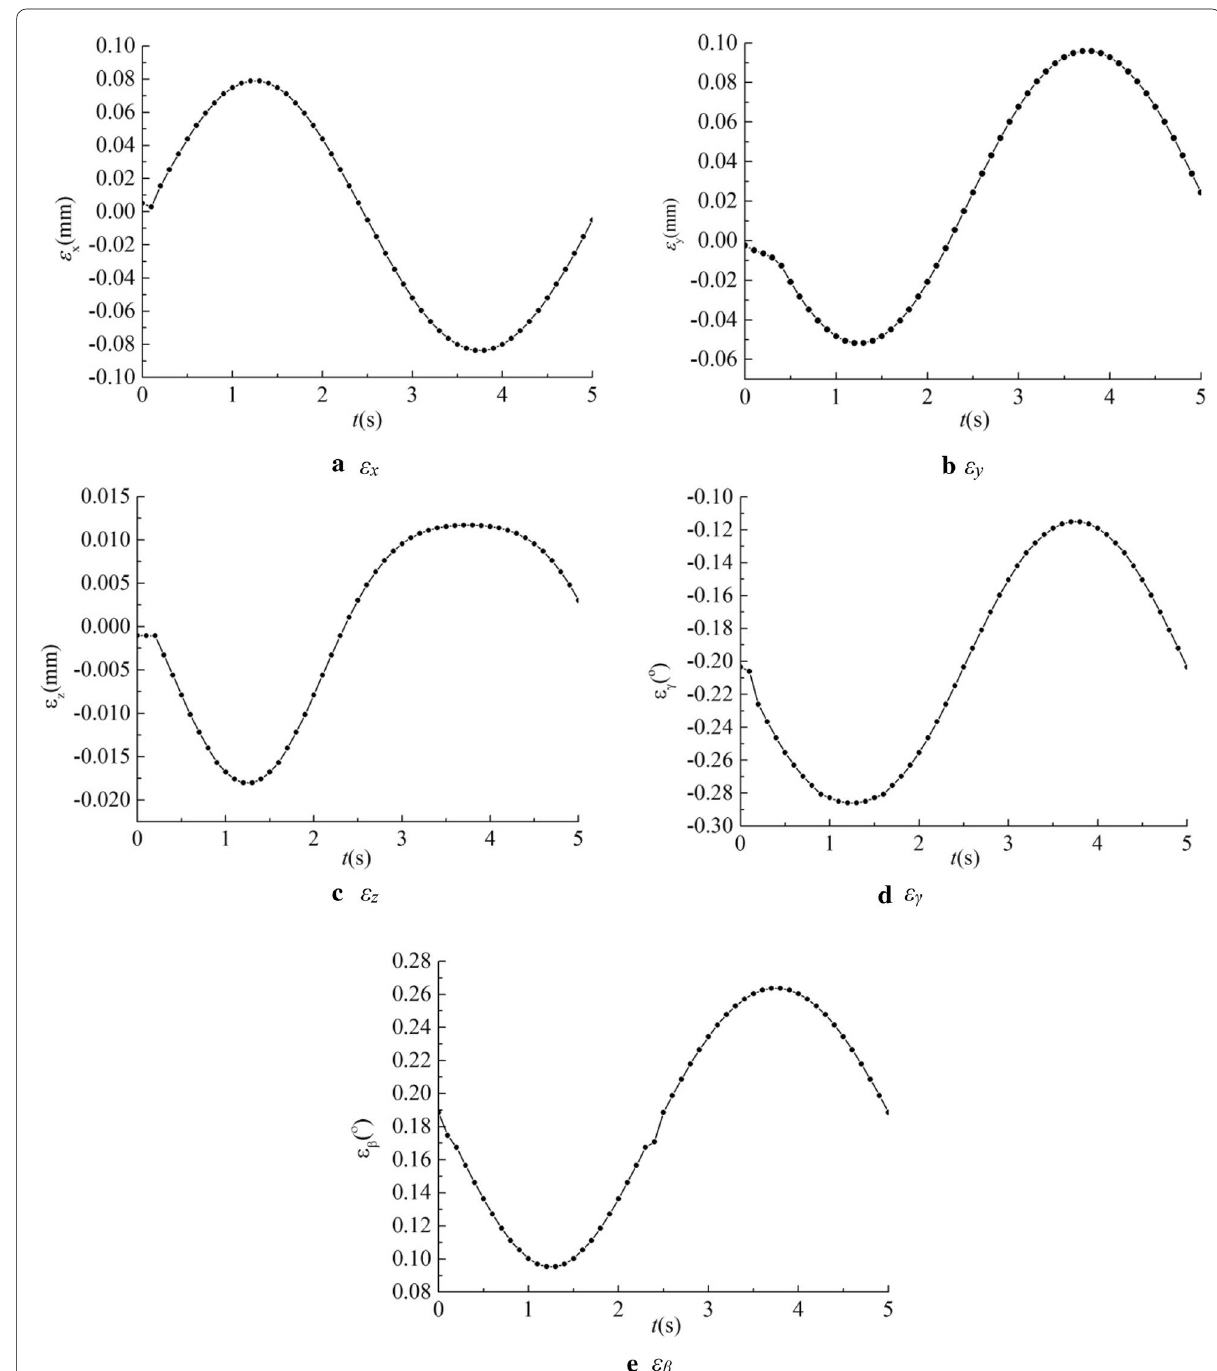
Figure 9 Displacement errors of moving platform: a Position error in direction X ; b Position error in direction Y ; c Position error in direction Z ; d Orientation error around X -axis; e Orientation error around Y